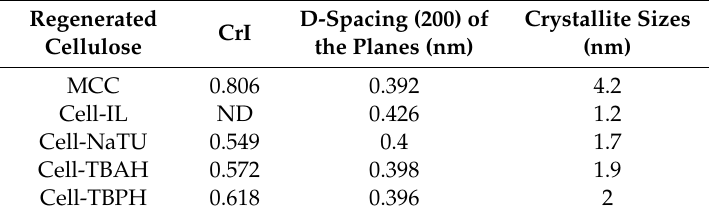
Table 2. XRD parameters of MCC and regenerated